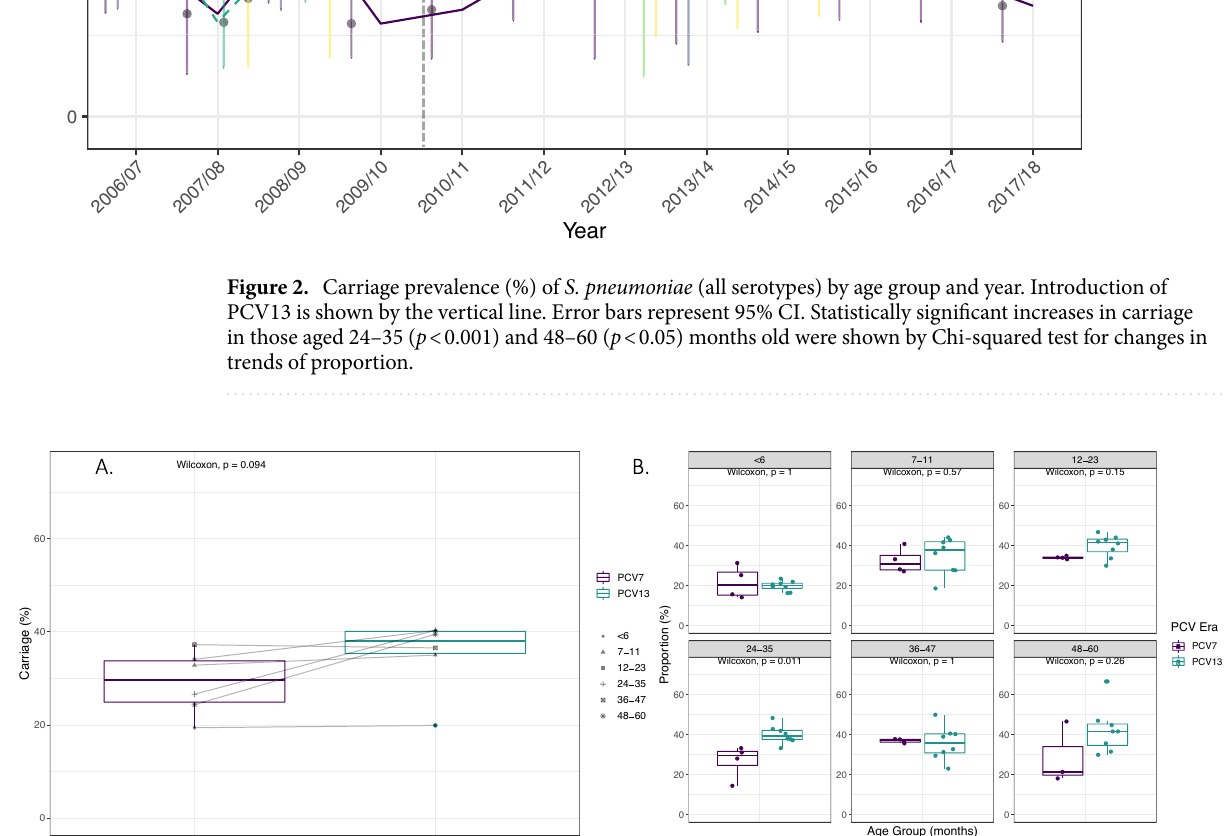
Figure 3. Comparison of overall pneumococcal carriage prevalence (%) by PCV era by all ages ( A ). and within age groups ( B ). Overall, no statistically significant difference was found between the PCV7 and PCV13 era, apart from in those aged 24–35 months, in whom a significant increase in carriage in the PCV13 era was observed ( p <